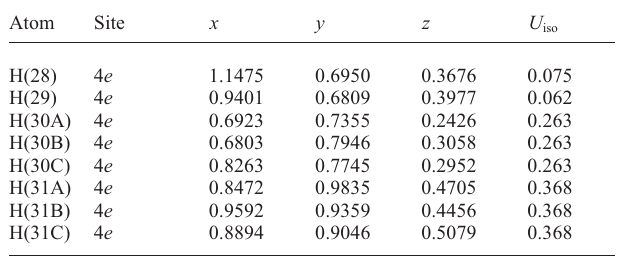
Table 3. Atomic coordinates and displacement parameters (in Å 2 )